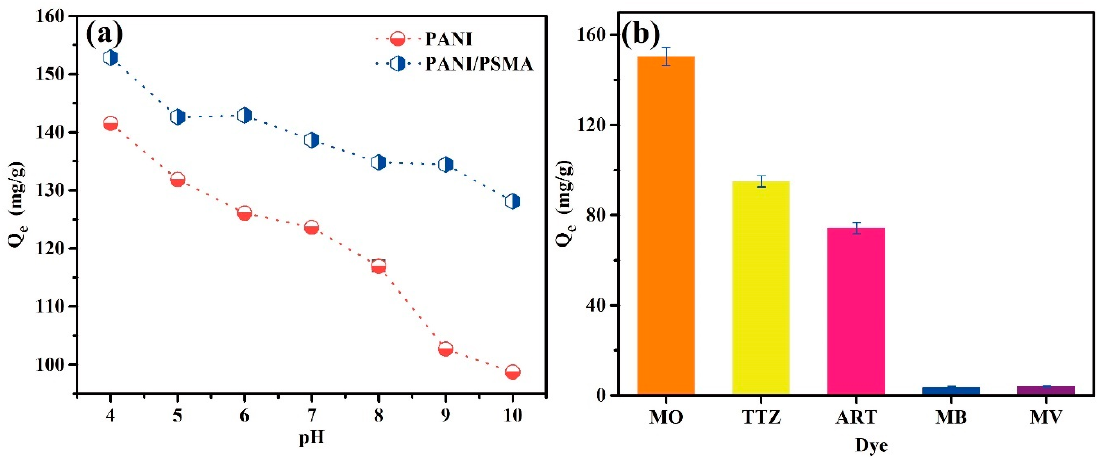
Figure 4. ( a ) The adsorption performance of PANI and PANI/PSMA for methyl orange (MO) at different pH. ( b ) Adsorption capacity of PANI/PSMA adsorption for different